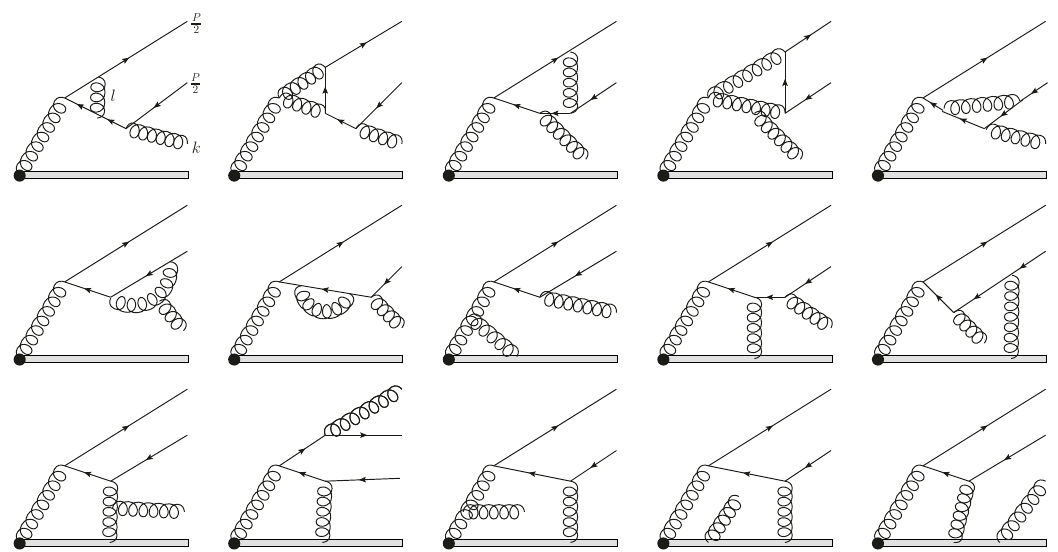
Figure 6 . Some typical Feynman diagrams of the virtual NLO correction for gluon fragmenting into 1 S [1] or 1 S [8] Q (cid:22) Q . The other diagrams are either self-energy diagrams for external legs 0 0